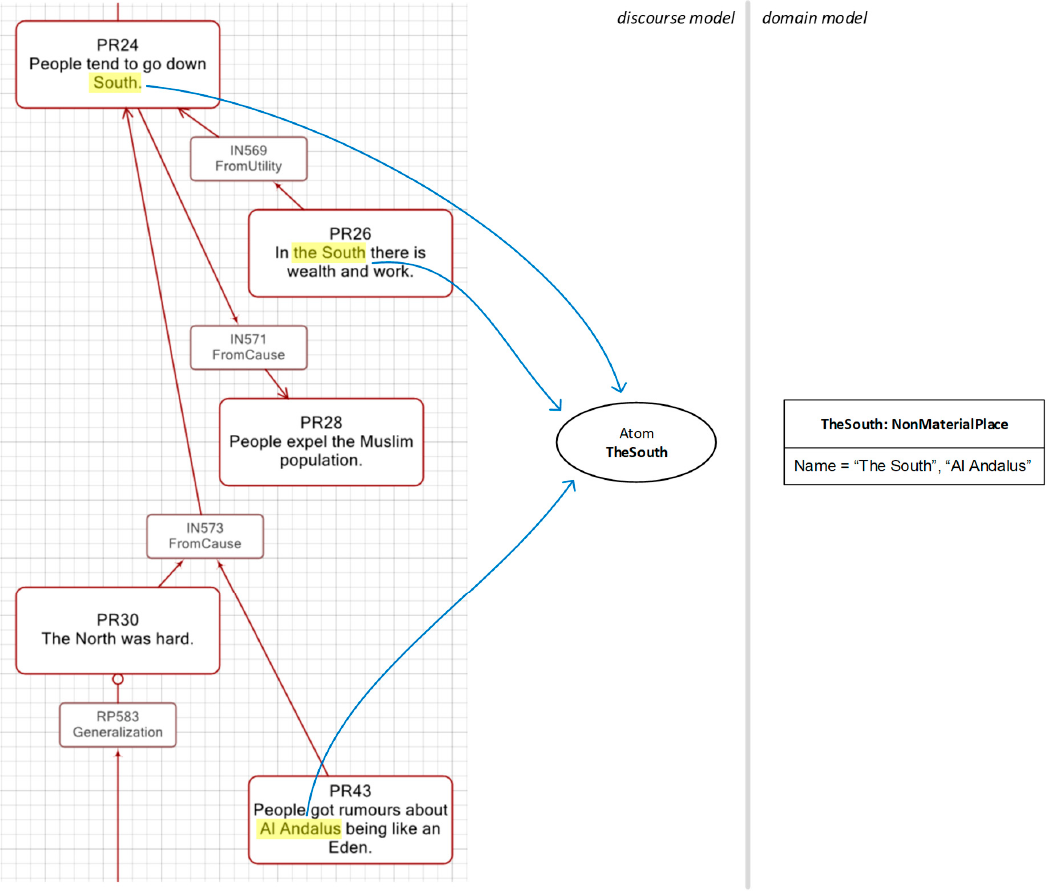
Figure 12. Discourse and domain models for the interpretation that “the South” and “Al Andalus” refer to the same thing.